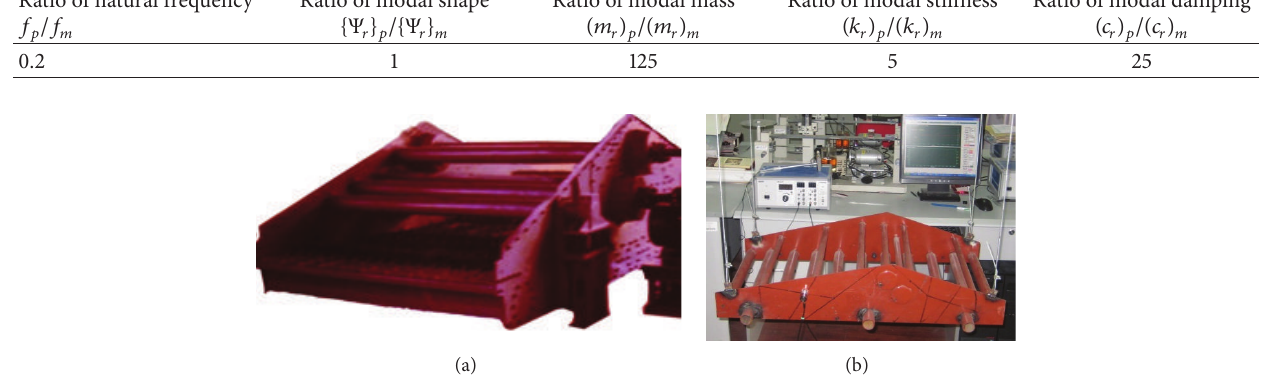
Figure 1: The prototype and model of the vibrating screen. (a) The prototype of 27 m 2 linear vibrating screen. (b) The 1: 5 scale model screen.